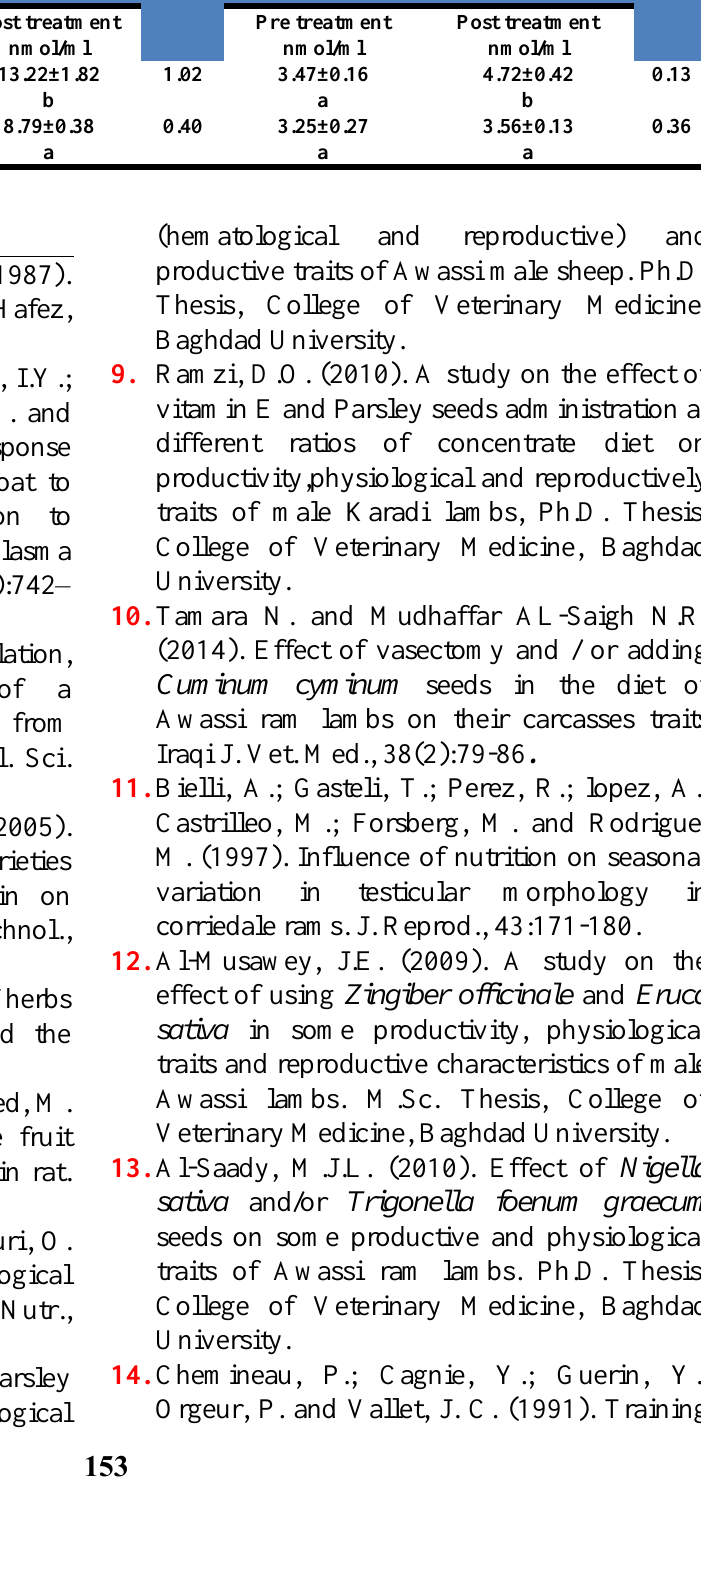
Table , 5: Effect of cumin seeds on serum cortisol and testosterone hormones level. (M ±SE). No. of Cortisol Groups Animals